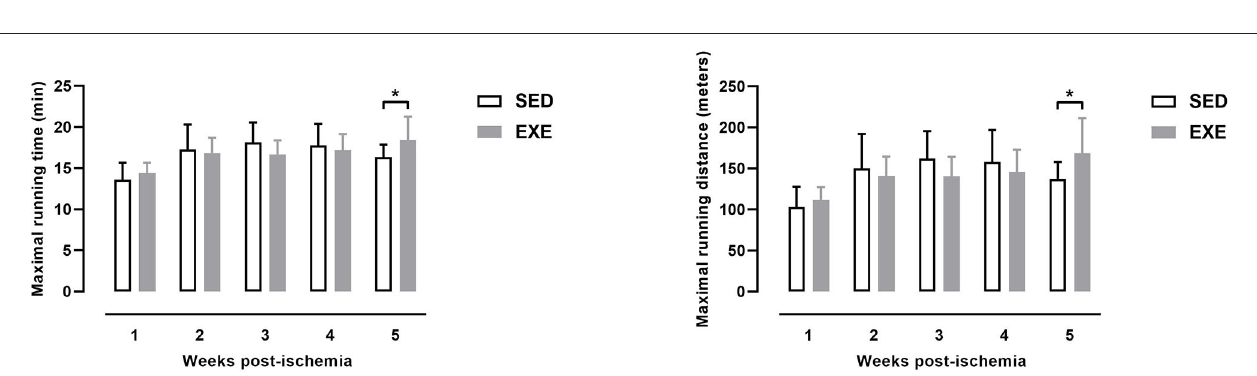
FIGURE 2 | Effect of preventive exercise on physical performance in ApoE − / − mice with PAD. Maximal running distance (left) and maximal running time (right) as measured on a graduated treadmill running test ( n = 11 animals per group). Unpaired t -test: * p < 0.05 vs. SED. Bar graphs represent mean ± SD. upregulated in ischemic muscle of EXE mice ( p < 0.01